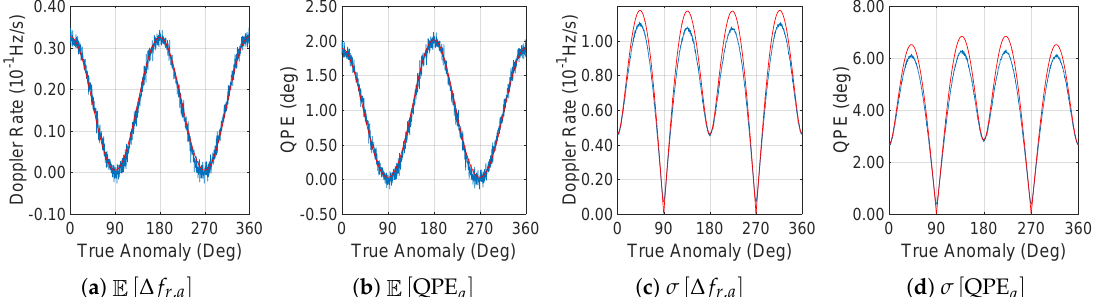
Figure 4. Acceleration vector term: numerical simulation results (blue) and analytical approximation results (red). The analytical approximation results are consistent with the numerical simulation results. The expected values in ( a , b ) no longer have an expected value of zero, indicating different characteristics from those of the velocity vector terms. The differences around 90 ◦ and 270 ◦ of true anomaly between the two sets of results in ( c , d ) are due to the ignored terms in the calculated true anomaly approximation